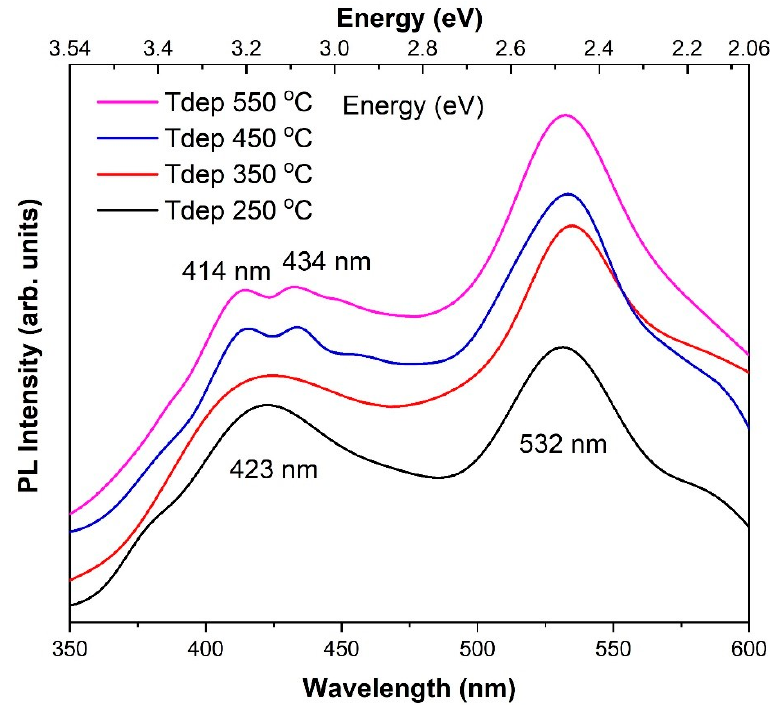
Figure 4. Photoluminescence (PL) spectra of ZrO 2 thin films measured at different annealing temperature.